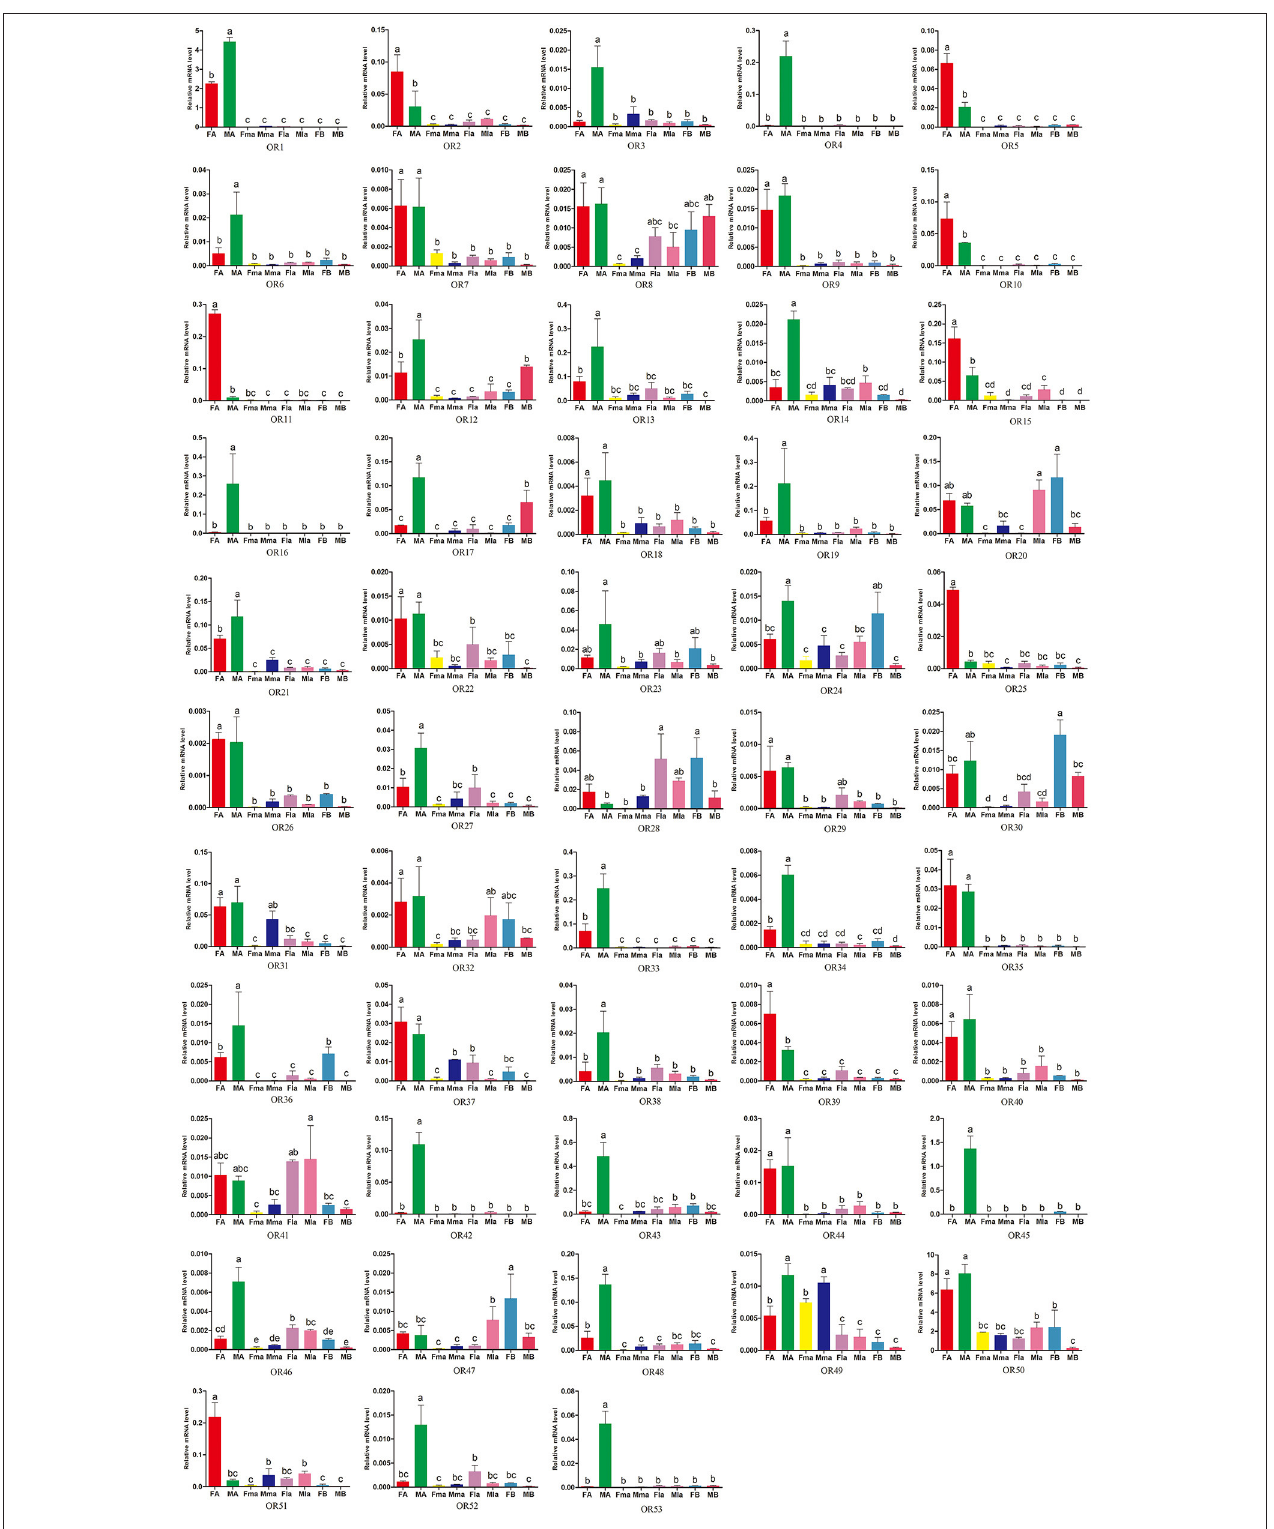
FIGURE 5 | Expression levels of A. chinensis ORs in different tissues of female and male adults as measured by RT-qPCR. FA: female antennae, MA: male antennae, Fma: female maxillary palps, Mma: male maxillary palps, Fla: female labial palps, FB: female bodies (with antennae, maxillary palps and labial palps cut off), MB: male bodies (with antennae, maxillary palps and labial palps cut off). The bar represents standard error and the different small letters (a–d) above each bar indicate significant differences ( P < 0.05).